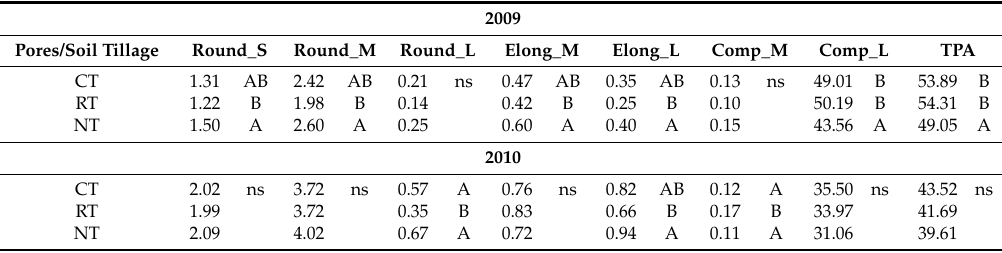
Table 3. Effect of the tillage systems on pore area percentage in the two years of the experiment and for the studied